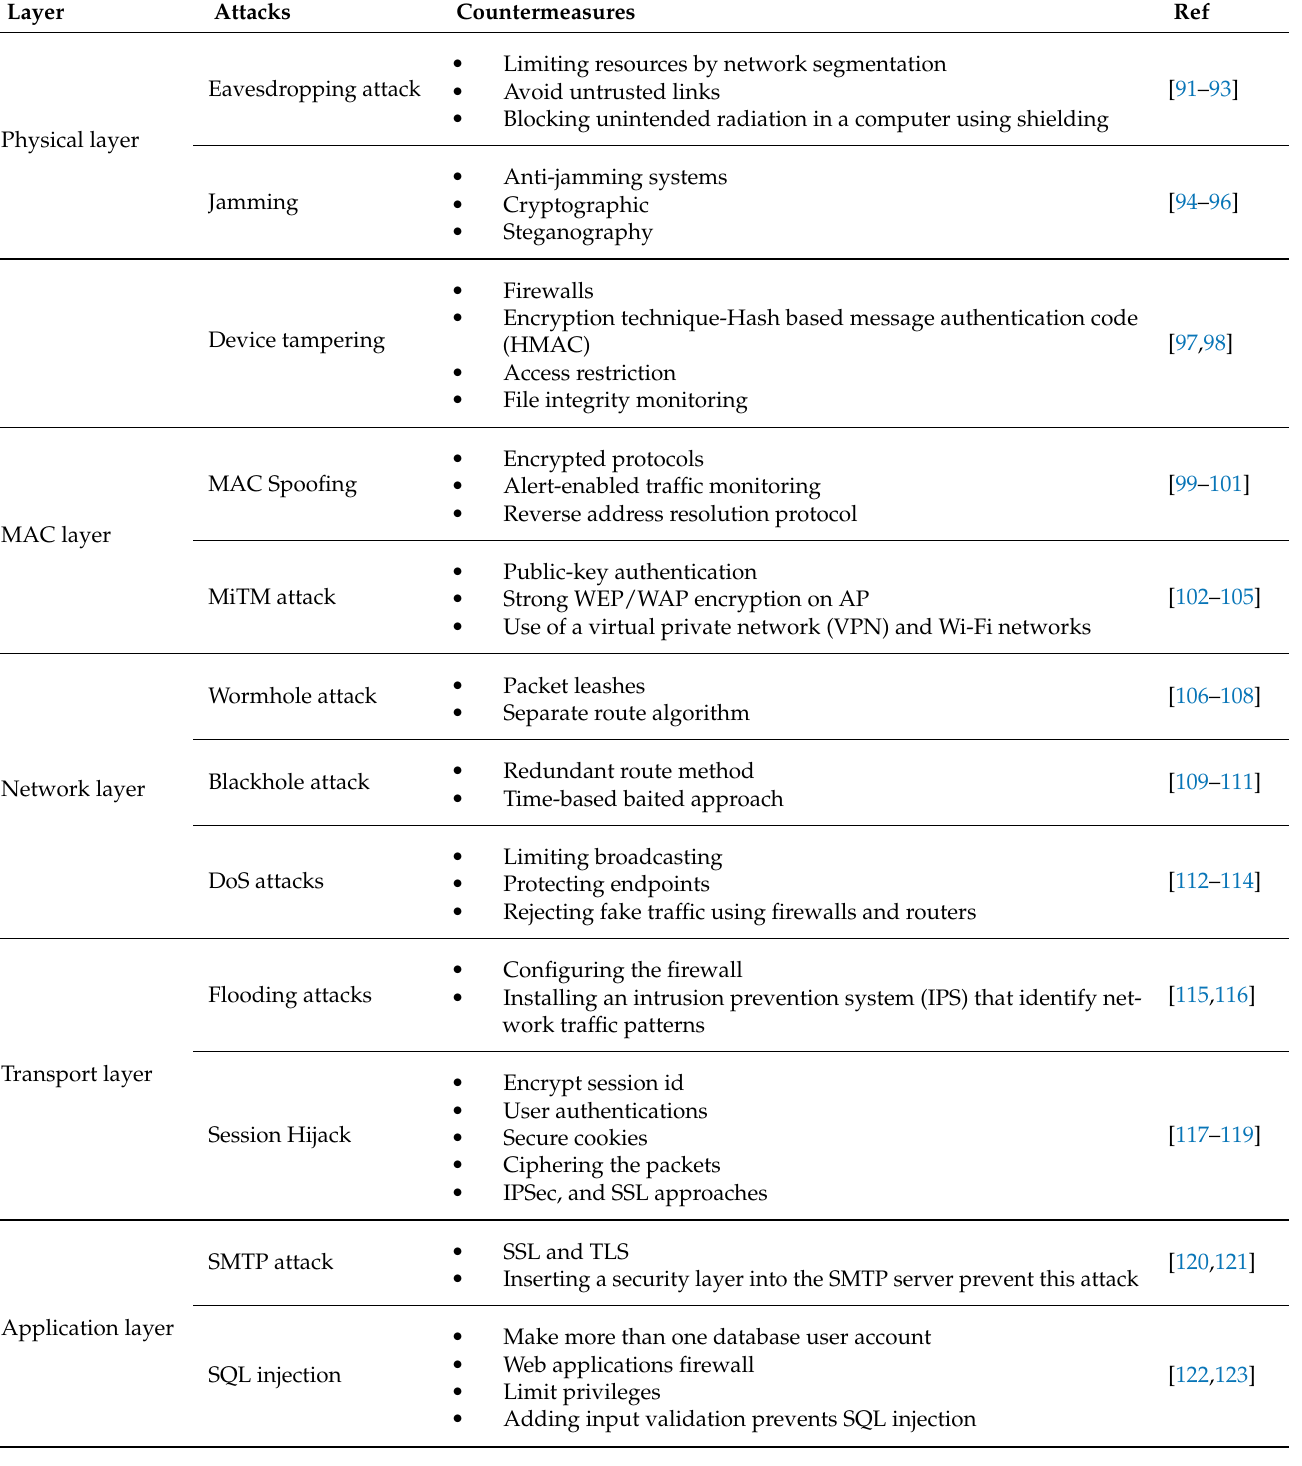
Table 2. Countermeasures for passive security attacks in different layers of